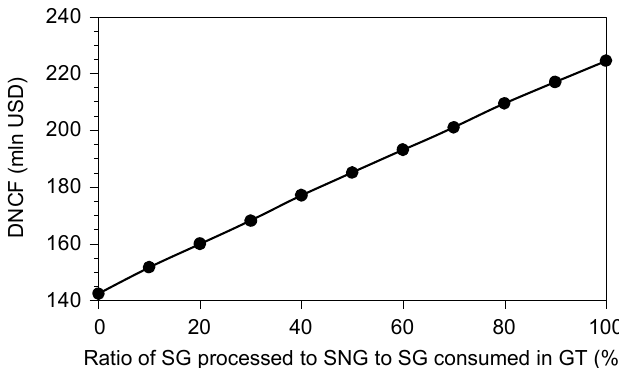
Figure 6. DNCF as a function of the SNG production rate.